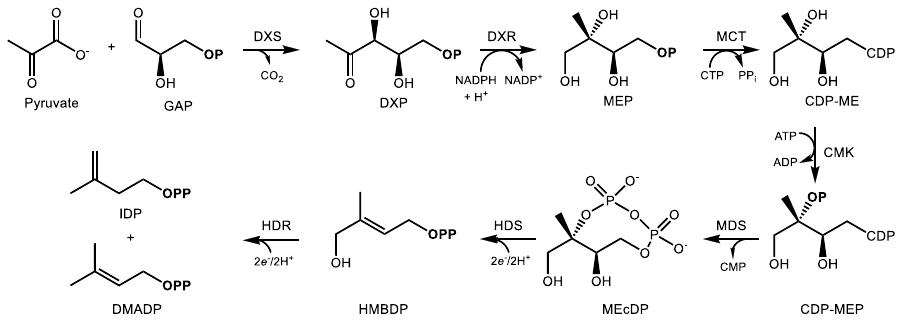
Figure 2. Biosynthesis of IDP and DMADP via the MEP pathway in the plastid. Enzyme abbreviations are as follows: DXS—1-deoxy- d -xylulose 5-phosphate synthase, DXR—1-deoxy- d -xylulose 5-phosphate reductoisomerase, MCT—2 C -methyl- d -erythritol 4-phosphate cytidyltransferase, CMK—4-(cytidine 5 (cid:48) -diphospho)-2 C -methyl- d -erythritol kinase, MDS—2 C -methyl- d -erythritol-2,4-cyclodiphosphate synthase, HDS—4-hydroxy-3-methylbut-2-enyl diphosphate synthase, HDR—4-hydroxy-3-methylbut-2-enyl diphosphate reductase. For intermediates, GAP— d -glyceraldehyde-3-phosphate, DXP—1-deoxy- d -xylulose 5-phosphate, MEP—2 C -methyl- d -erythritol 4-phosphate, CDP–cytidyl diphosphate, MEcDP—2 C -methyl- d -erythritol-2,4-cyclodiphosphate, HMBDP—1-hydroxy-2-methyl-2-( E )-butenyl-4-diphosphate, IDP—isopentenyl diphosphate, DMADP—dimethylallyl diphosphate; OP and